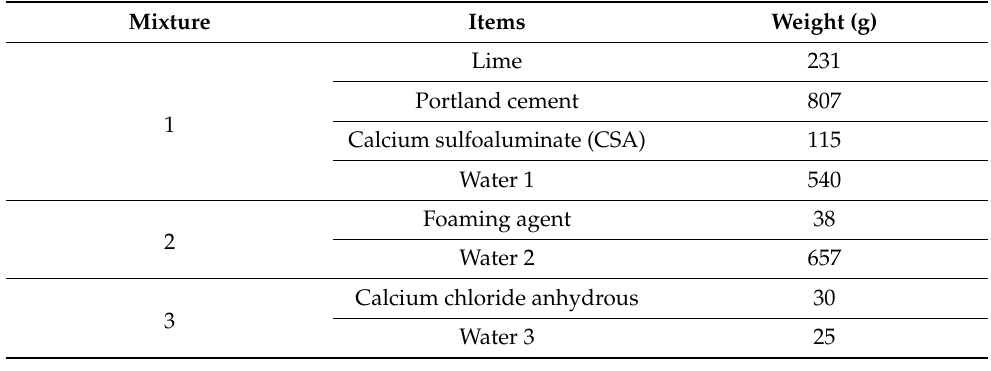
Table 7. Formula for foam concrete with a density of 0.2 g/cm 3 .